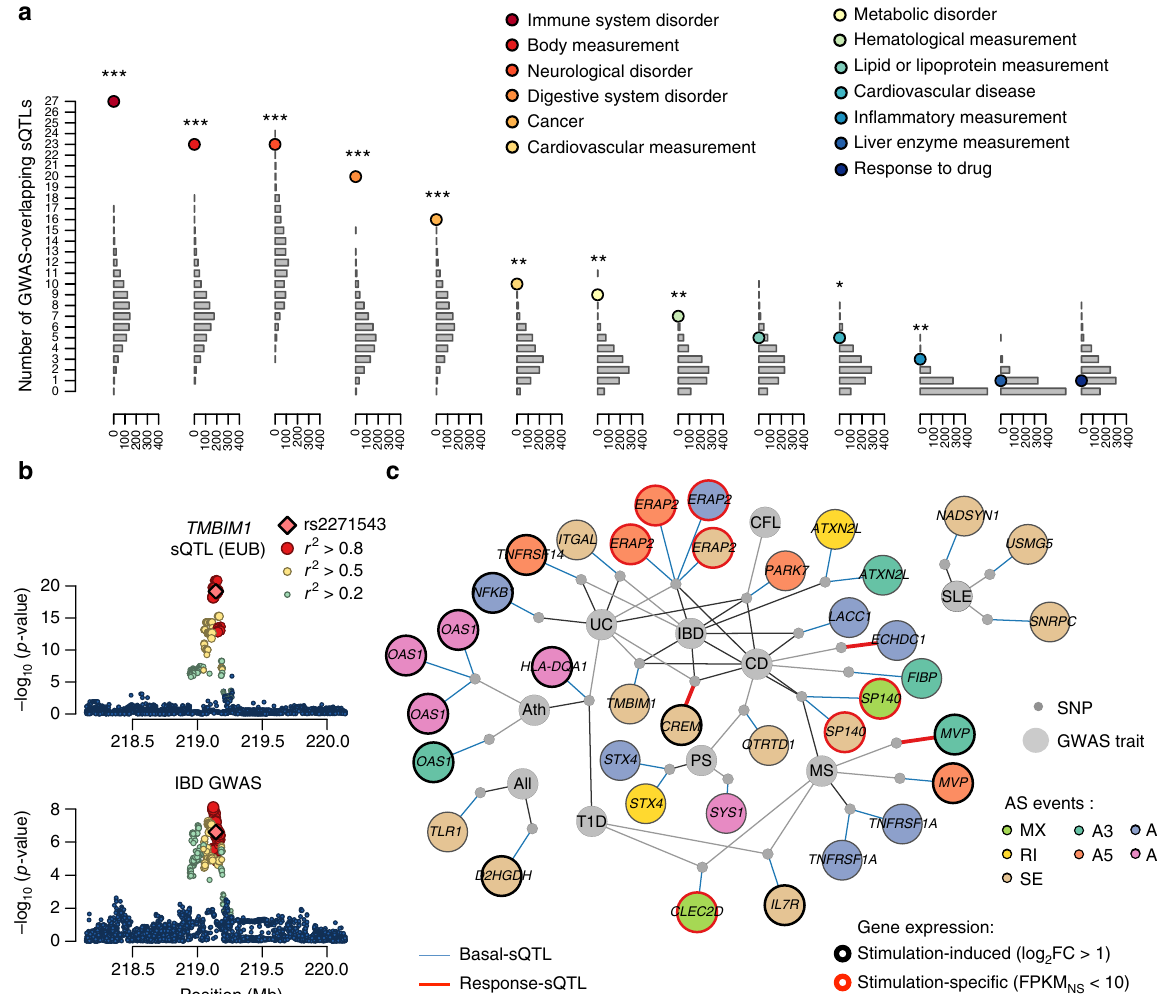
Fig. 5 Innate immunity sQTLs contribute to complex traits and immune disorders. a Enrichment of sQTLs in GWAS hits. For each trait/disease category, coloured dots show the number of sQTLs overlapping a GWAS locus. Grey bars represent the distribution of the expected number of GWAS hits when resampling 1000 random SNPs matched for minor allele frequency (resampling p -value, * p < 0.05, ** p < 0.01, *** p < 0.001). b Log 10 ( p -value) pro fi les of the TMBIM1 sQTL (upper panel) and GWAS for in fl ammatory bowel disease (IBD, lower panel). SNPs are coloured according to their LD ( r 2 ) with the sQTL peak SNP and putative causal variant rs2271543. Only SNPs where both sQTLs and GWAS summary statistics were available are shown. c sQTLs colocalizing with GWAS loci for 10 major immune-related disorders (grey nodes, Ath asthma, All allergy, CEL celiac disease, CD Crohn ’ s disease, IBD in fl ammatory bowel disease, MS multiple sclerosis, PS psoriasis, SLE systemic lupus erythematous, T1D type-1 diabetes, UC ulcerative colitis). For each sQTL, genetic variants are represented by grey dots and are linked to the associated AS event (coloured nodes, named after their associated gene). AS events are coloured by class of event and circled according to gene expression patterns upon stimulation (black: upregulated — log 2 FC > 1 in at least one condition, red: speci fi c to stimulation — FPKM < 10 at basal state and log 2 FC > 1). Links between AS events and sQTLs indicate stimulation-speci fi city of the genetic association (blue edge for sQTLs, red for response sQTLs — p -value > 0.001 at basal state and p rsQTL < 0.01). Links between sQTLs and GWAS traits indicate colocalization ( r 2 > 0.8 between sQTLs and GWAS SNPs in Europeans) and are coloured according to the strength of the GWAS association (grey: GWAS p < 10 − 5 , black: GWAS p < 10 − 8 ). Source data are provided as a Source Data fi